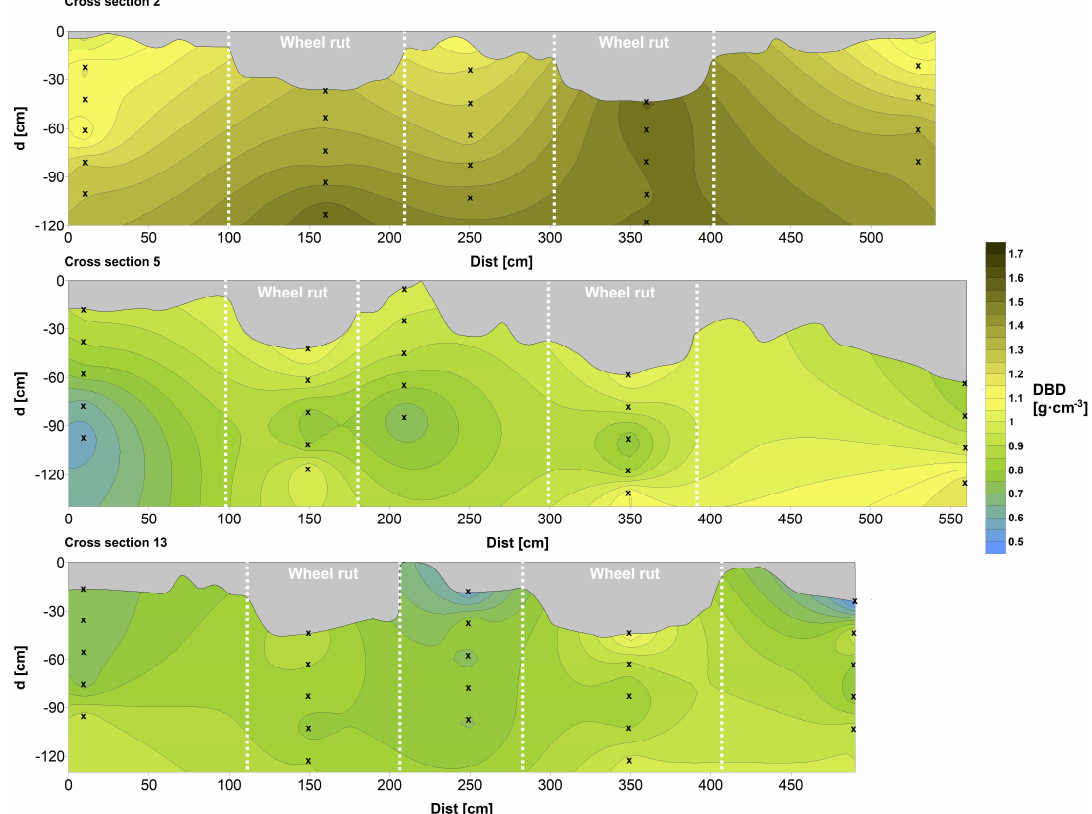
Figure 5. Exemplary interpolated DBD cross sections (upper slope (2), middle slope (5), lower slope (13)); relative position of wheel ruts and sampling points are